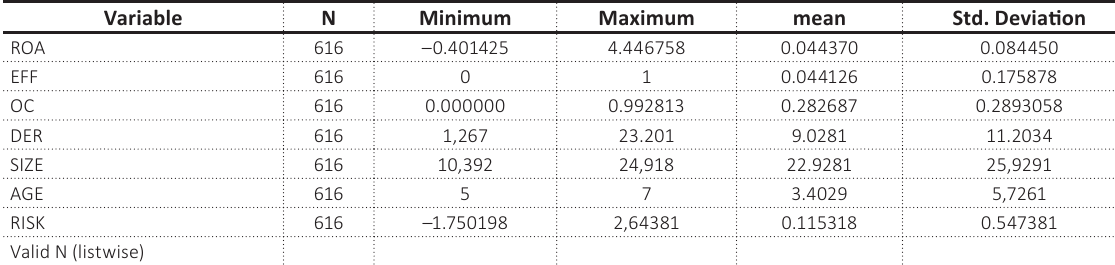
Table 4. Hypothesis testing